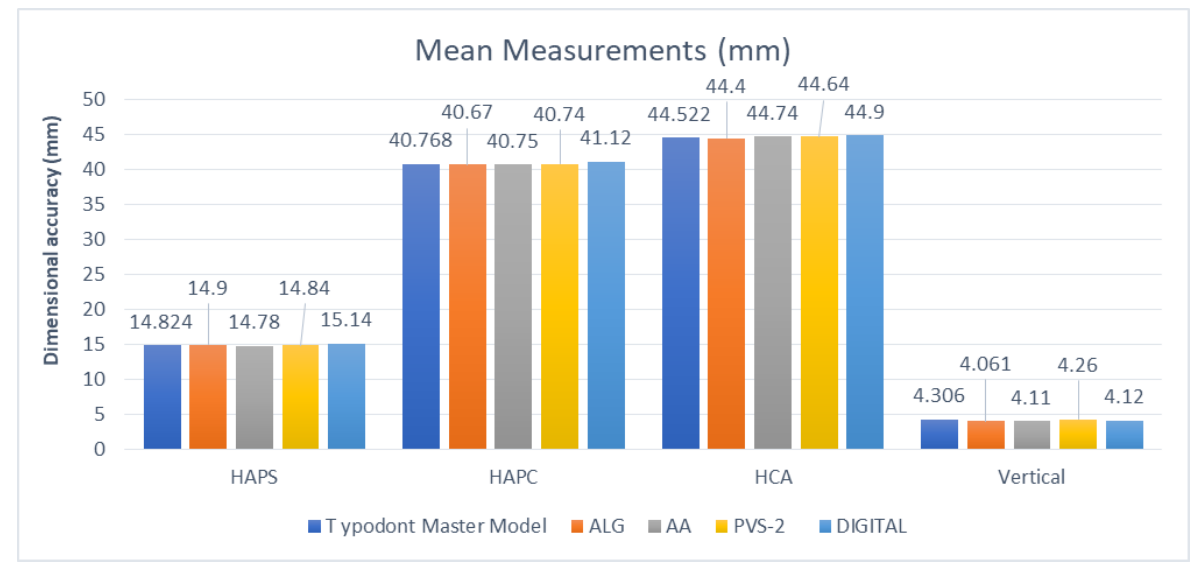
Figure 5. Measurements of stone casts, printed models, and the typodont master model (mm).